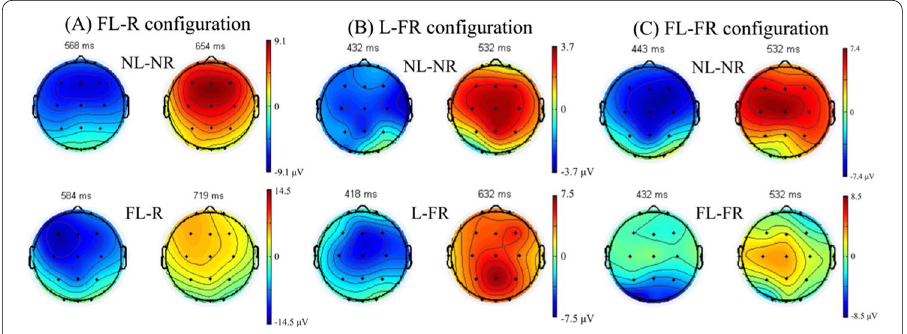
Fig. 6 Topographic maps of the N400 and P600 components elicited by standard and deviant stimuli in a FL-R, b L-FR, and c FL-FR